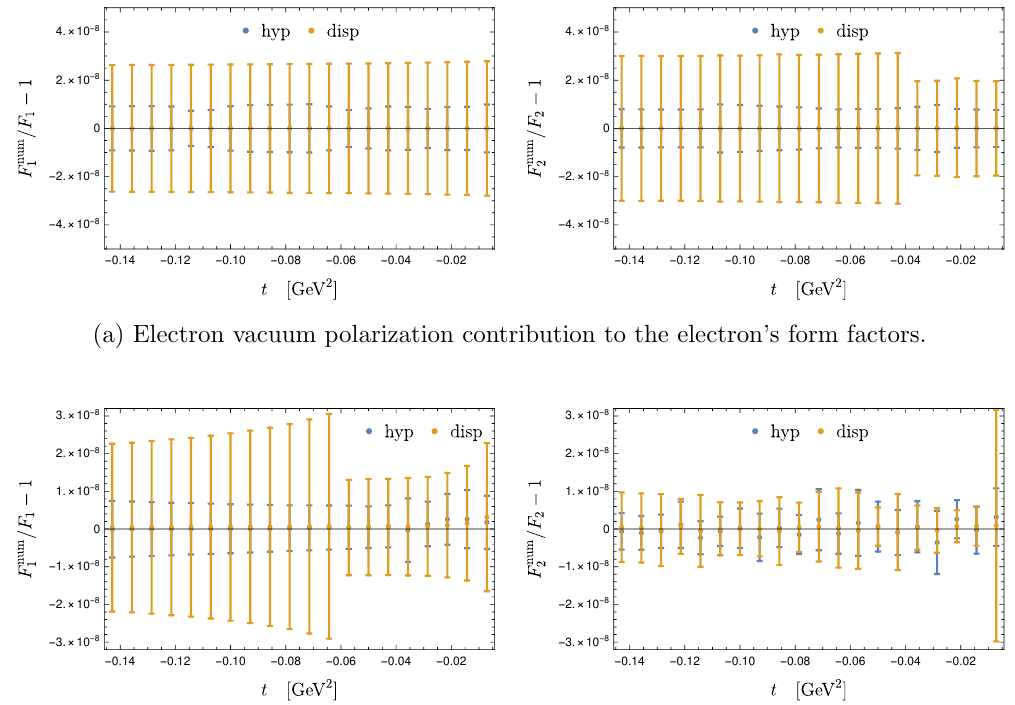
obtained by the i